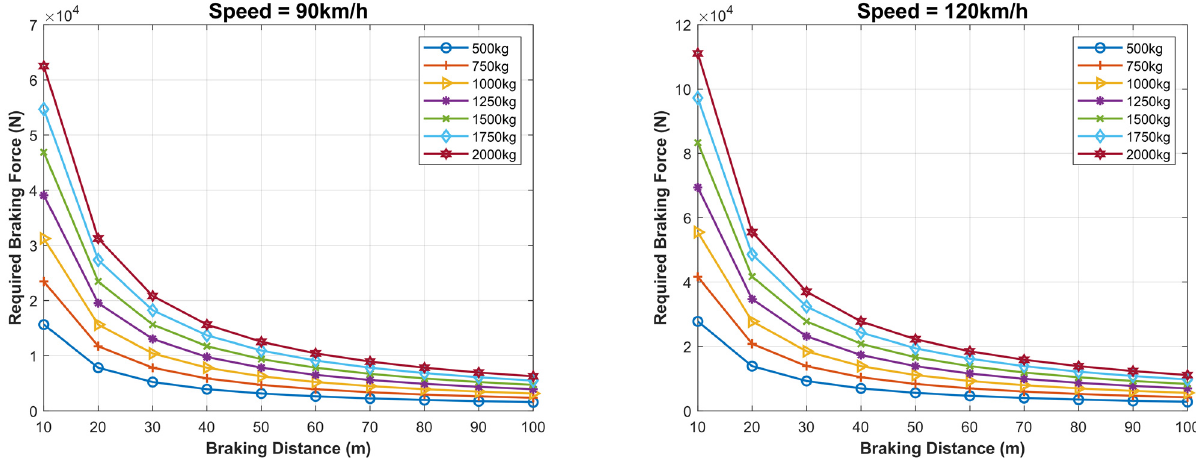
Figure 24. Required braking force as a function of the vehicle mass for different speeds and braking distances.